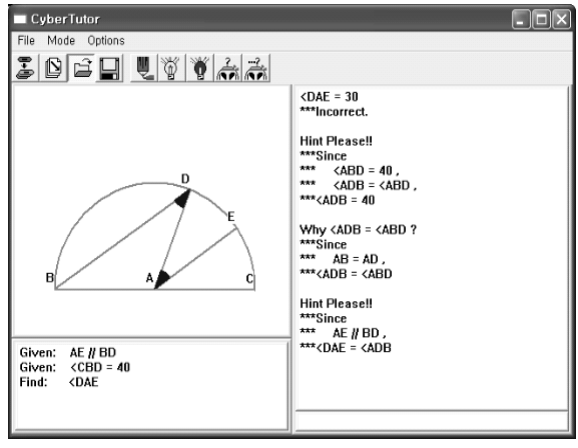
Fig. 5. The CyberTutor